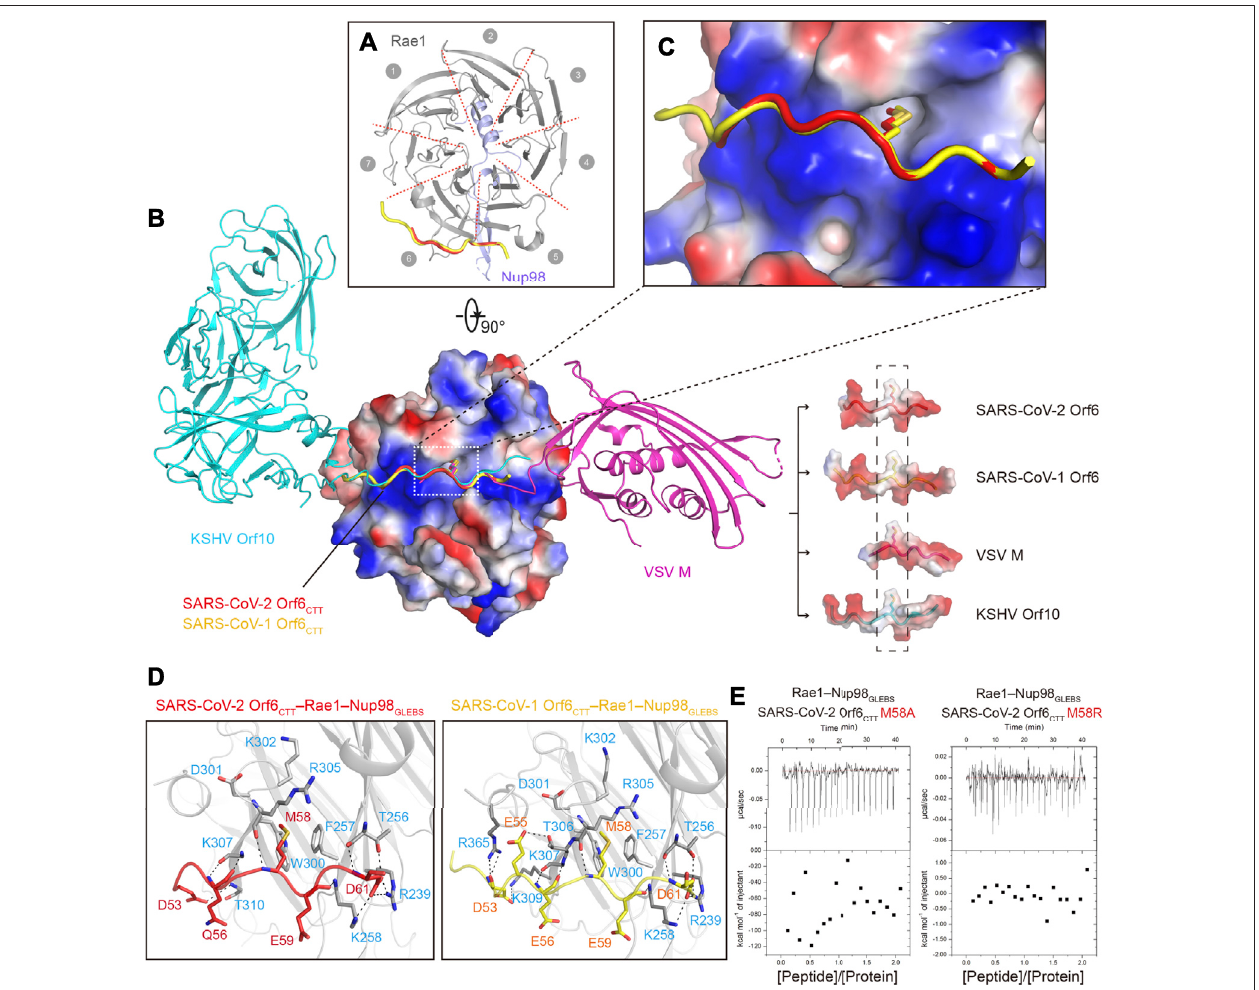
FIGURE2| CrystalstructuresofSARS-CoVs Orf6 CTT – Rae1 – Nup98 GLEBS . (A) RibbonrepresentationofSARS-CoVs Orf6 CTT – Rae1 – Nup98 GLEBS intopview,with the same color code as in Figure 1A . Structures of SARS-CoV-2 Orf6 CTT and SARS-CoV-1 Orf6 CTT are overlaid to show the same binding site on the Rae1 – Nup98 complex. (B) StructuralsuperpositionofSARS-CoVsOrf6 CTT ,VSVM – Rae1 – Nup98 GLEBS (PDBID:4OWR),andKSHVOrf10 – Rae1 – Nup98 GLEBS (PDBID:7BYF).VSVM and KSHV Orf10 are colored with magentas and cyan, respectively. The Rae1 – Nup98 GLEBS complex and the interacting region of four viral proteins are shown in electrostatic potential surface representation. The conserved methionine residues are shown as sticks. (C) Surface electrostatic potential plot of the Rae1 – Nup98 complex to show the environment around M58 of SARS-CoVs Orf6. (D) Residues of Rae1 participating in interactions with SARS-CoV-2 Orf6 (left) and SARS-CoV-1 (right) are shown as stick models in gray. Hydrogen bonds are shown as black dashed lines. (E) Binding isotherms for the interaction of SARS-CoV-2 Orf6 mutants (M58A and M58R) with the Rae1 – Nup98 GLEBS